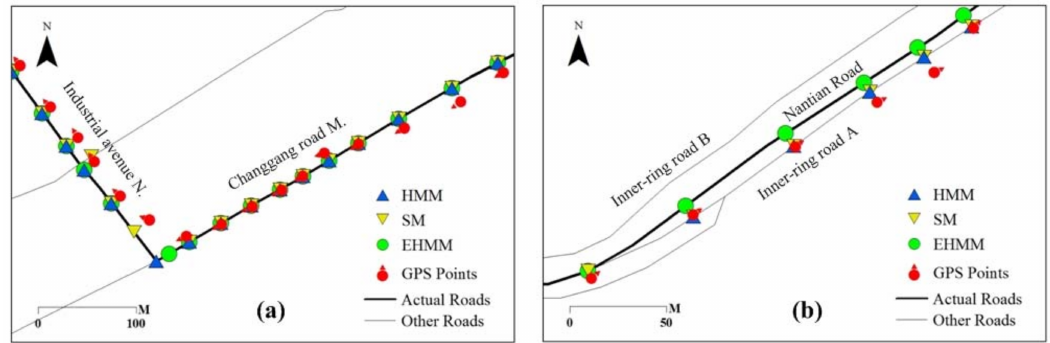
Figure 6. Comparison of matching performance among the various models on simple roads ( a ) and complex roads ( b